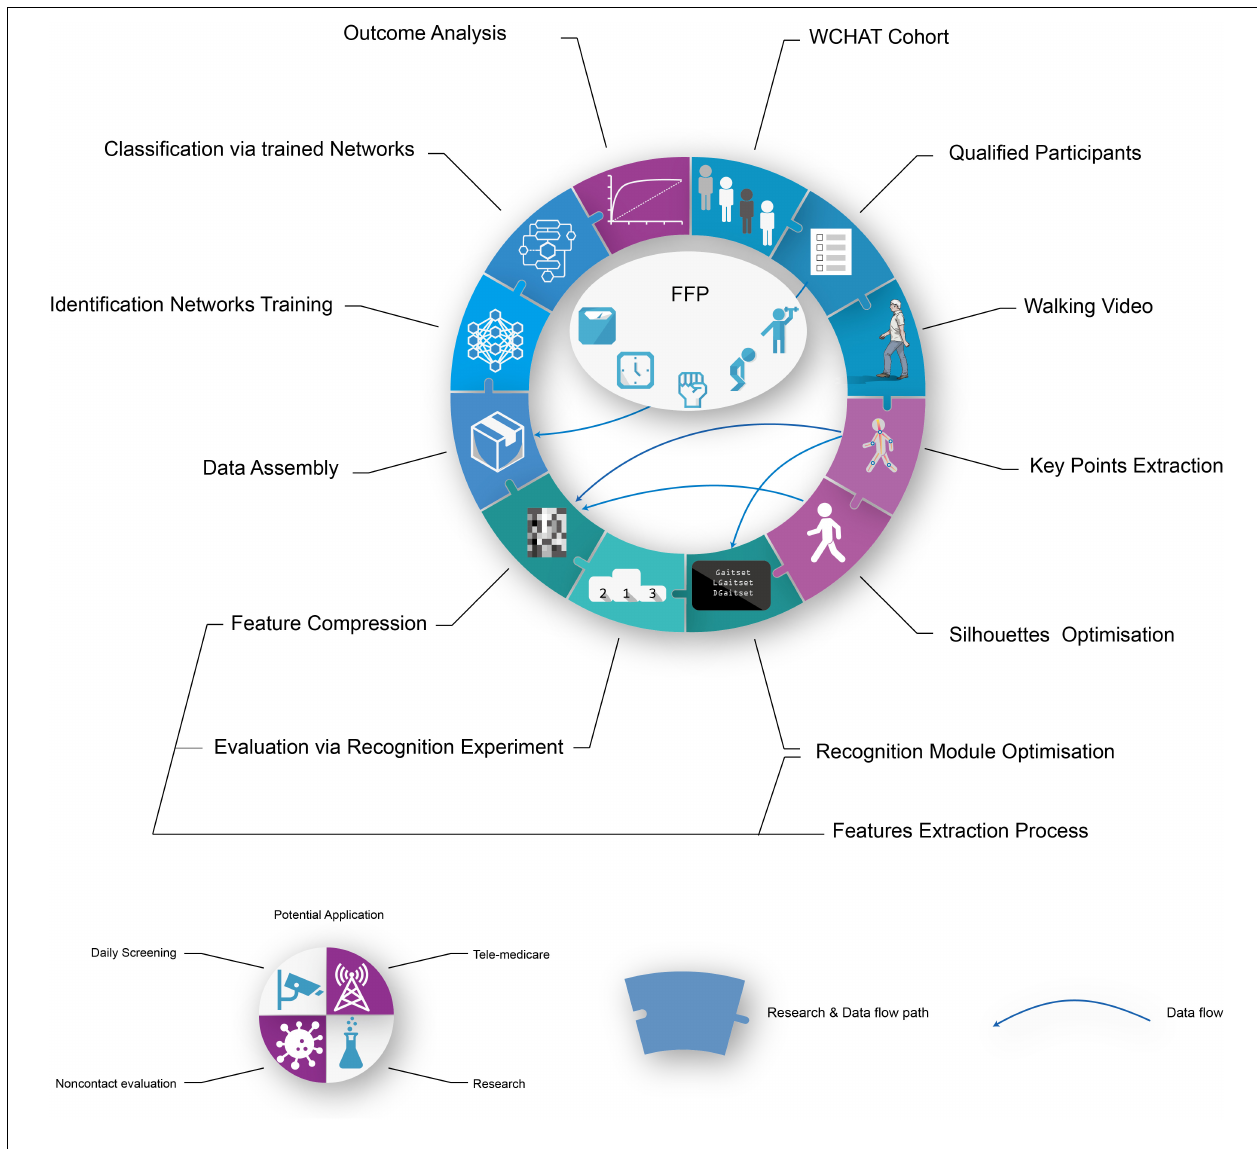
FIGURE 1 | Visualised abstract. FFP, Fried Frail phenotype